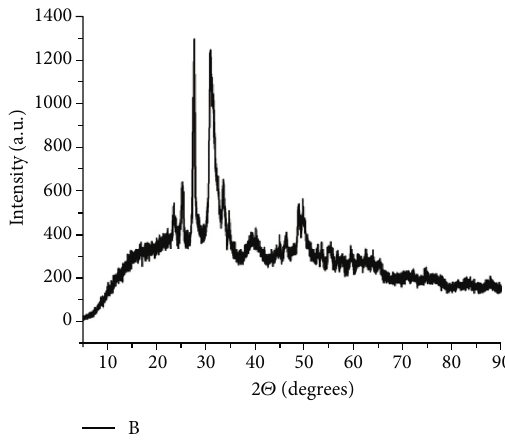
Figure 1: XRD of nanoZrO